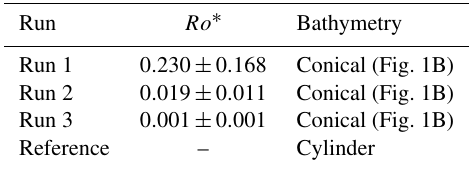
Table 1. Test cases. Values of the Rossby numbers ( Ro ) in our sim-